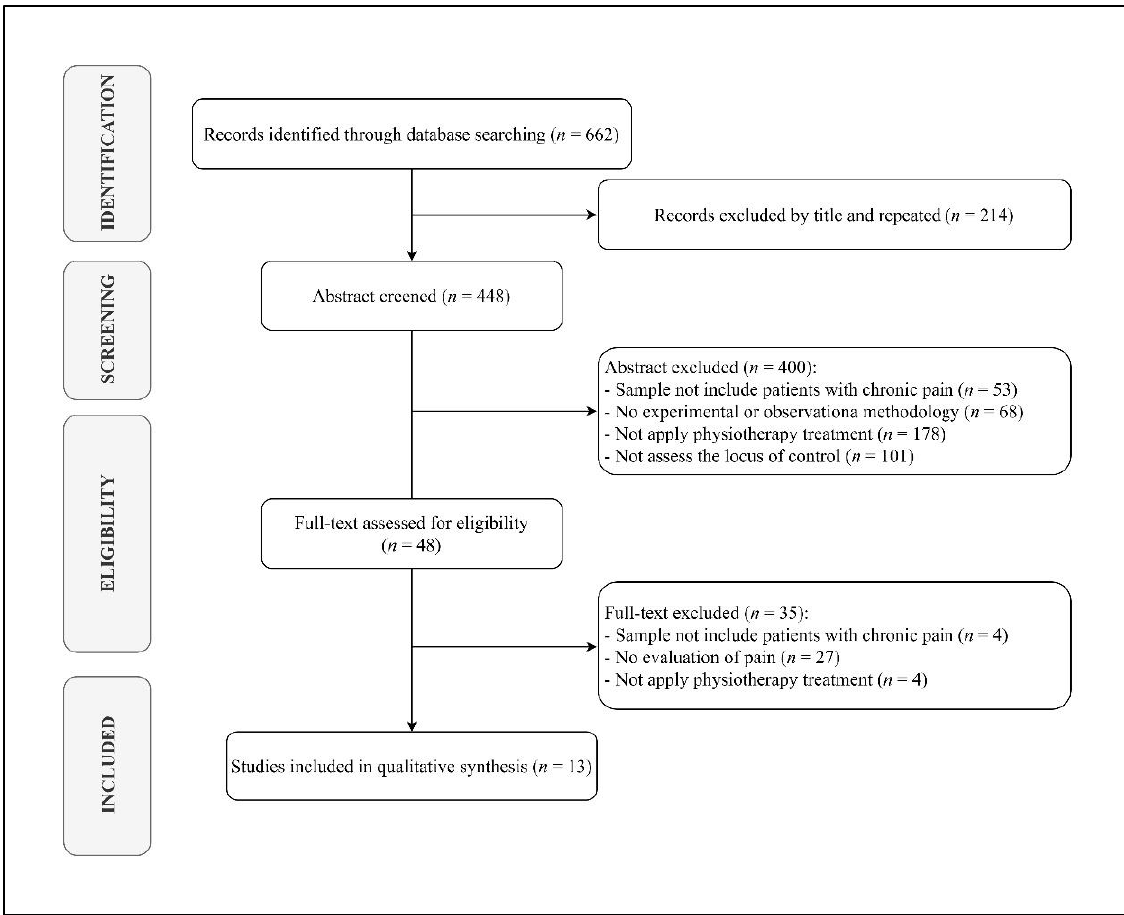
Figure 1. PRISMA flow diagram.